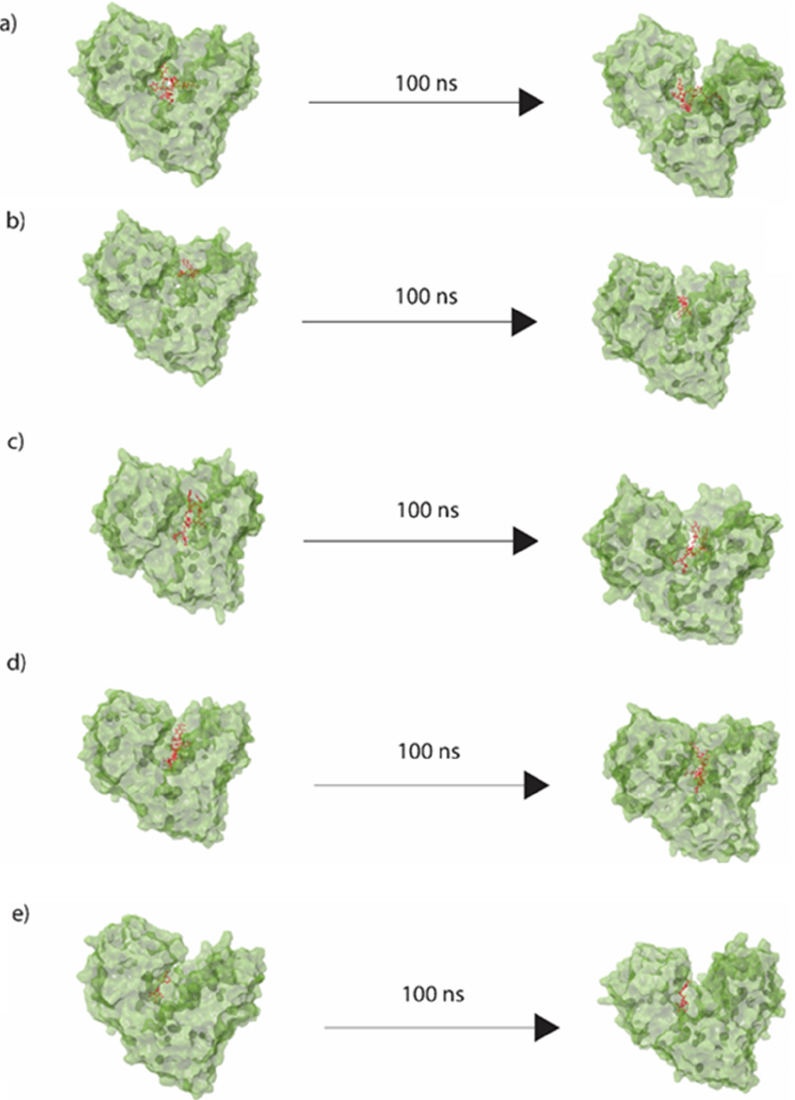
Figure 5. Best docked poses of ( a ) desmopressin, ( b ) rutin, ( c ) lypressin, ( d ) lanreotide, and ( e ) 68T, showing the movement of the ligands during the 100 ns molecular dynamics simulations, with initial and final